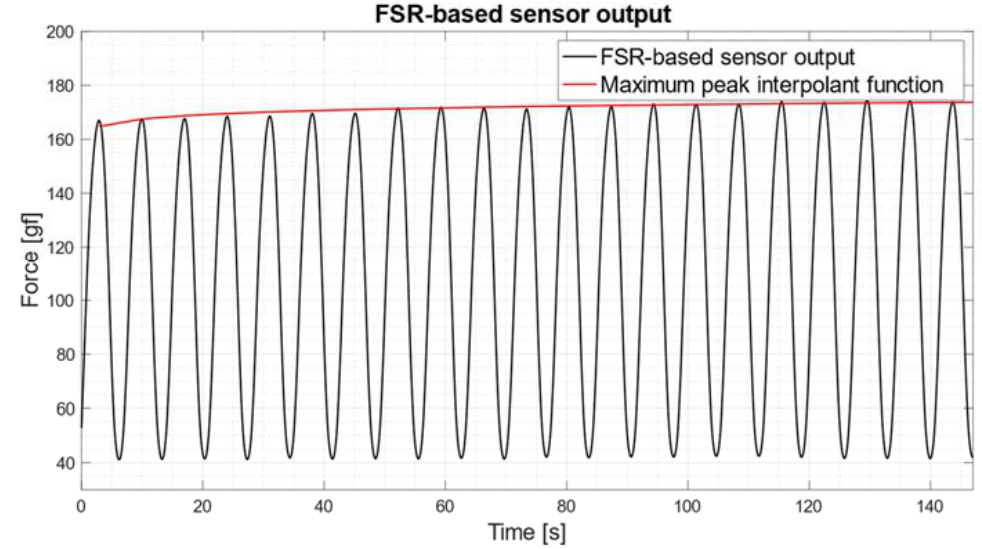
Figure 12. FSR-based sensor output and interpolation function of its maximum peaks (red line) for motor stress frequency of 0.09 Hz (motor power supply set to 1 V).